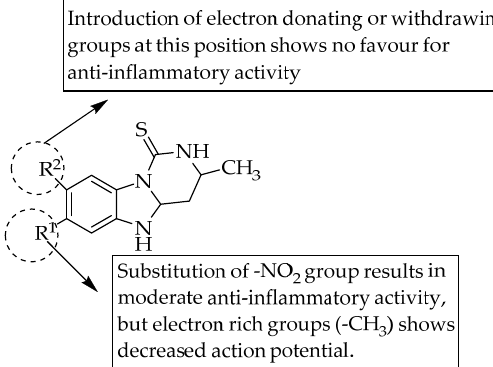
Figure 45. SARs of tetrahydropyrimido[1,6-a]benzimidazol-1(2H)-thione.